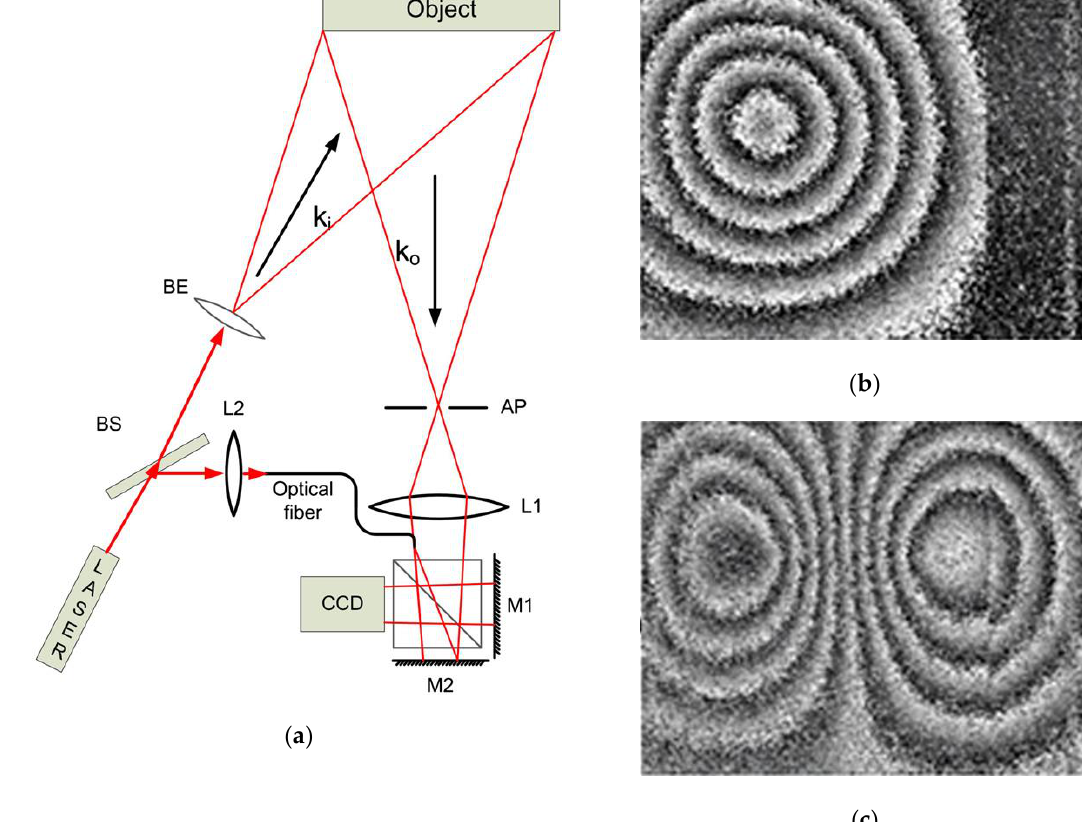
Figure 10. ( a ) The SPS-DS setup for out-of-plane deformation and its first derivative measurement; ( b ) phase map of a hologram; ( c ) phase map of a shearogram.